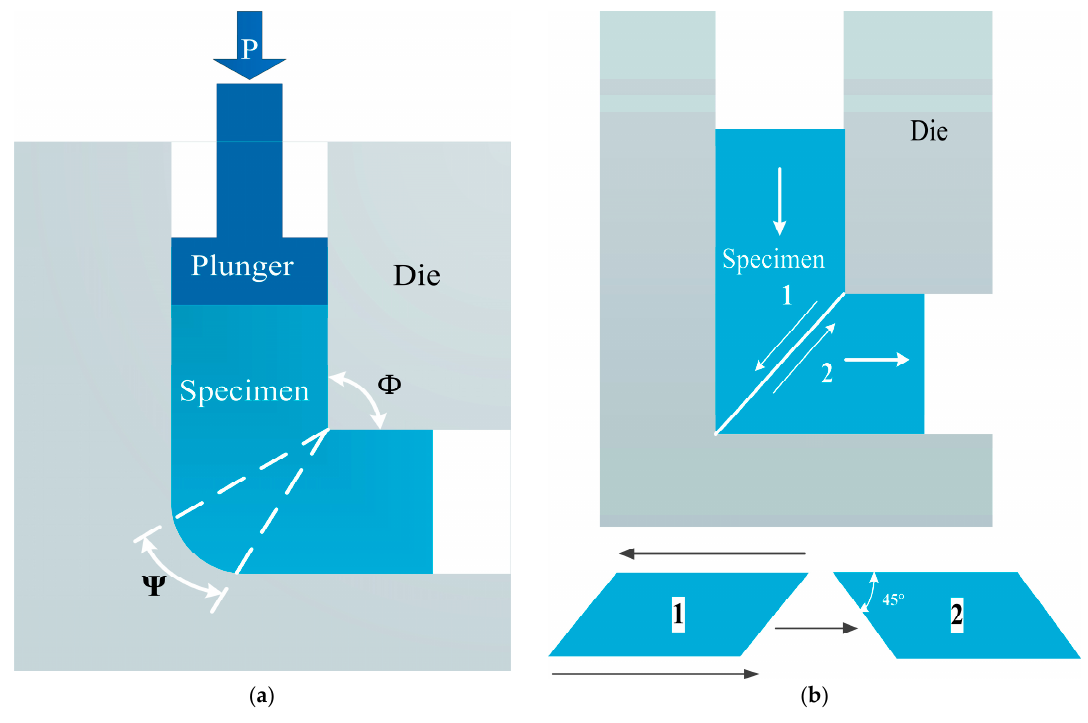
Figure 1. ( a ) The schematic illustration of a typical ECAP (equal channel angular pressing) facility; ( b ) The principle of ECAP showing the shearing plane existing in the die.